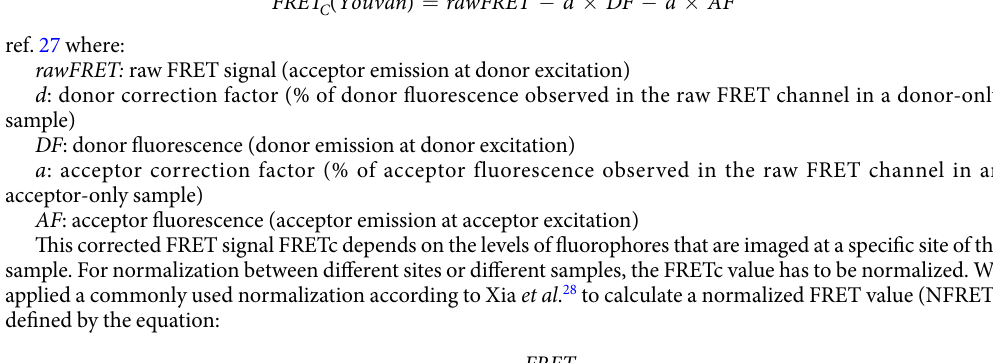
ref. 27 where: rawFRET: raw FRET signal (acceptor emission at donor excitation) d : donor correction factor (% of donor fluorescence observed in the raw FRET channel in a donor-only sample) DF : donor fluorescence (donor emission at donor excitation) a : acceptor correction factor (% of acceptor fluorescence observed in the raw FRET channel in an acceptor-only sample) AF : acceptor fluorescence (acceptor emission at acceptor